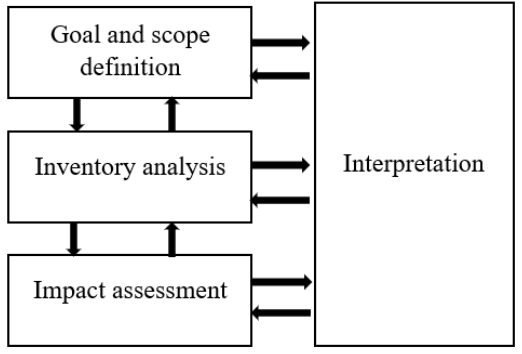
Figure 2. The frameworks of LCA according to ISO 14040 [24].